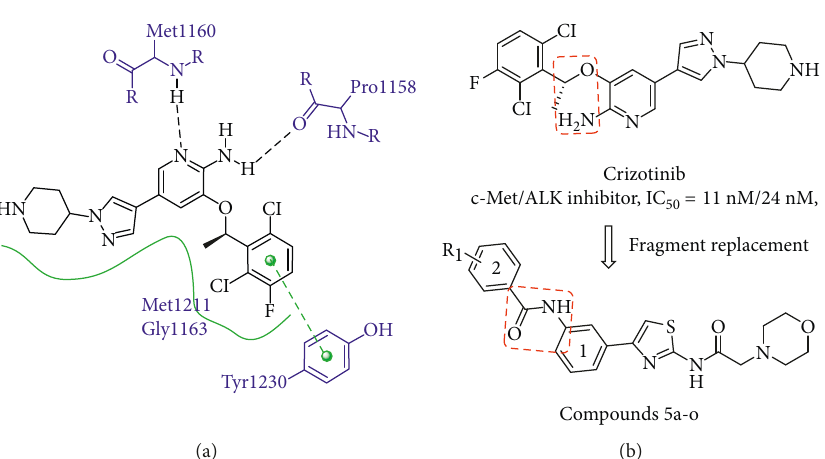
Figure 2: (a) Cocrystal structure of crizotinib bound to c-Met (2WGJ). Black dashed line indicates hydrogen bonds. Green solid line shows hydrophobic interactions, and green dashed line shows π - π interactions. (b) Design of novel target compounds based on